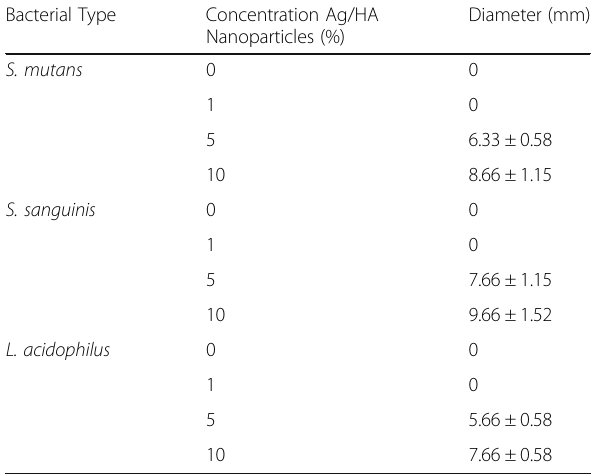
Table 1 Average diameters of bacterial growth inhibition zones (mm)